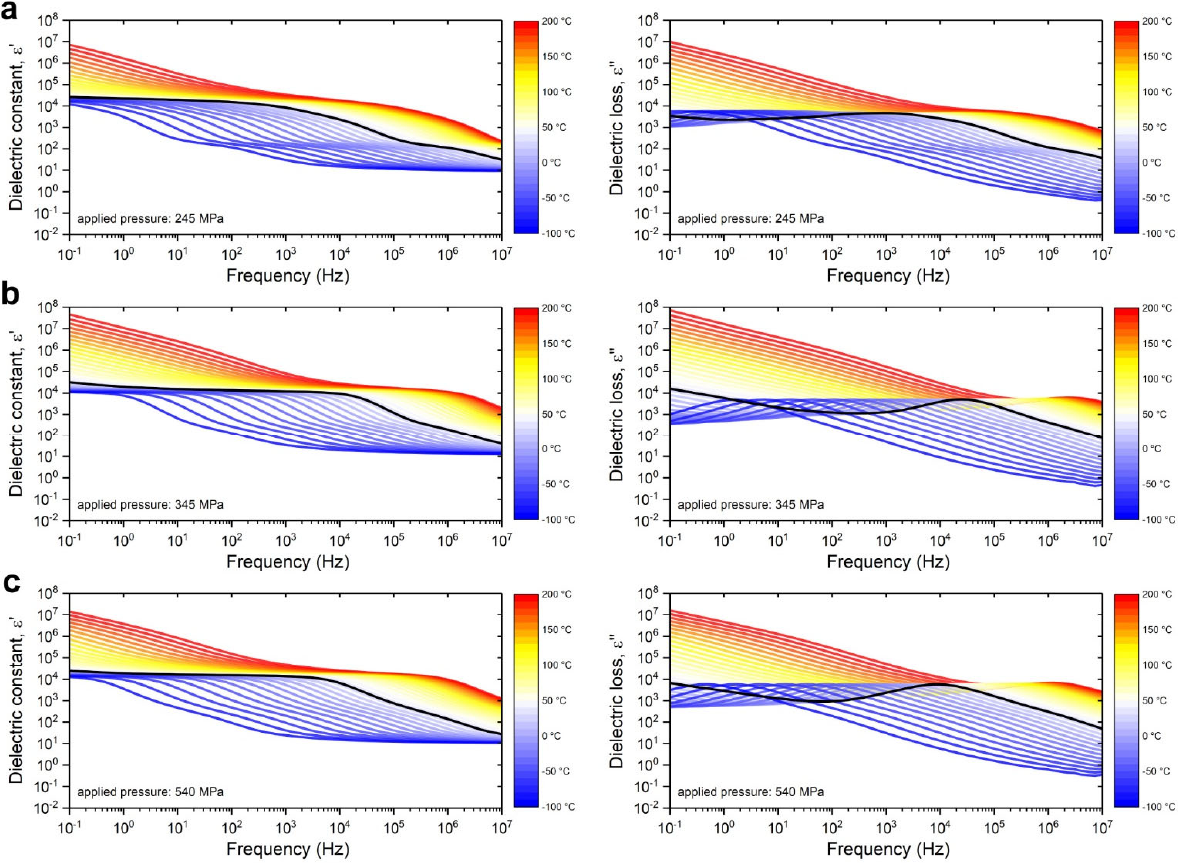
Figure 11. Real and imaginary components of permittivity, ε ’ (dielectric constant) and ε ’’ (dielectric loss), respectively, scanned over the broadband frequency range of 10 − 1 to 10 11 Hz and for temperatures ranging from 200 °C to − 100 °C. Scans for NASICON pellets assembled by applying isostatic pressure levels of ( a ) 245 MPa, ( b ) 345 MPa, and ( c ) 540 MPa are displayed. Temperature profiles are plotted according to the common colormaps displayed on the right of figures; scans corresponding to RT (25 °C) are highlighted in bold.